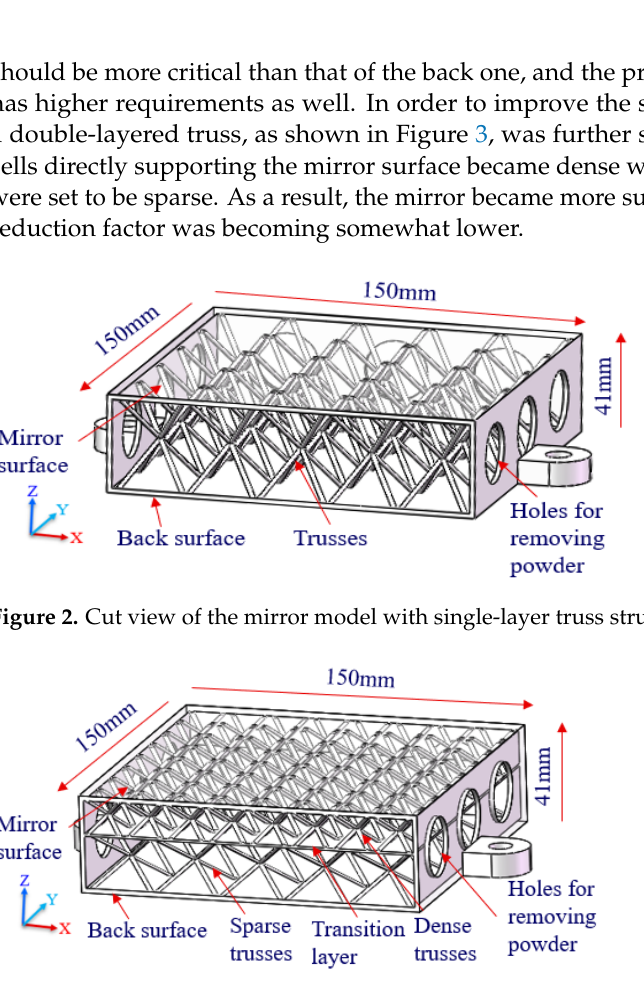
Figure 3. Cut view of the mirror model with double-layer truss structure.